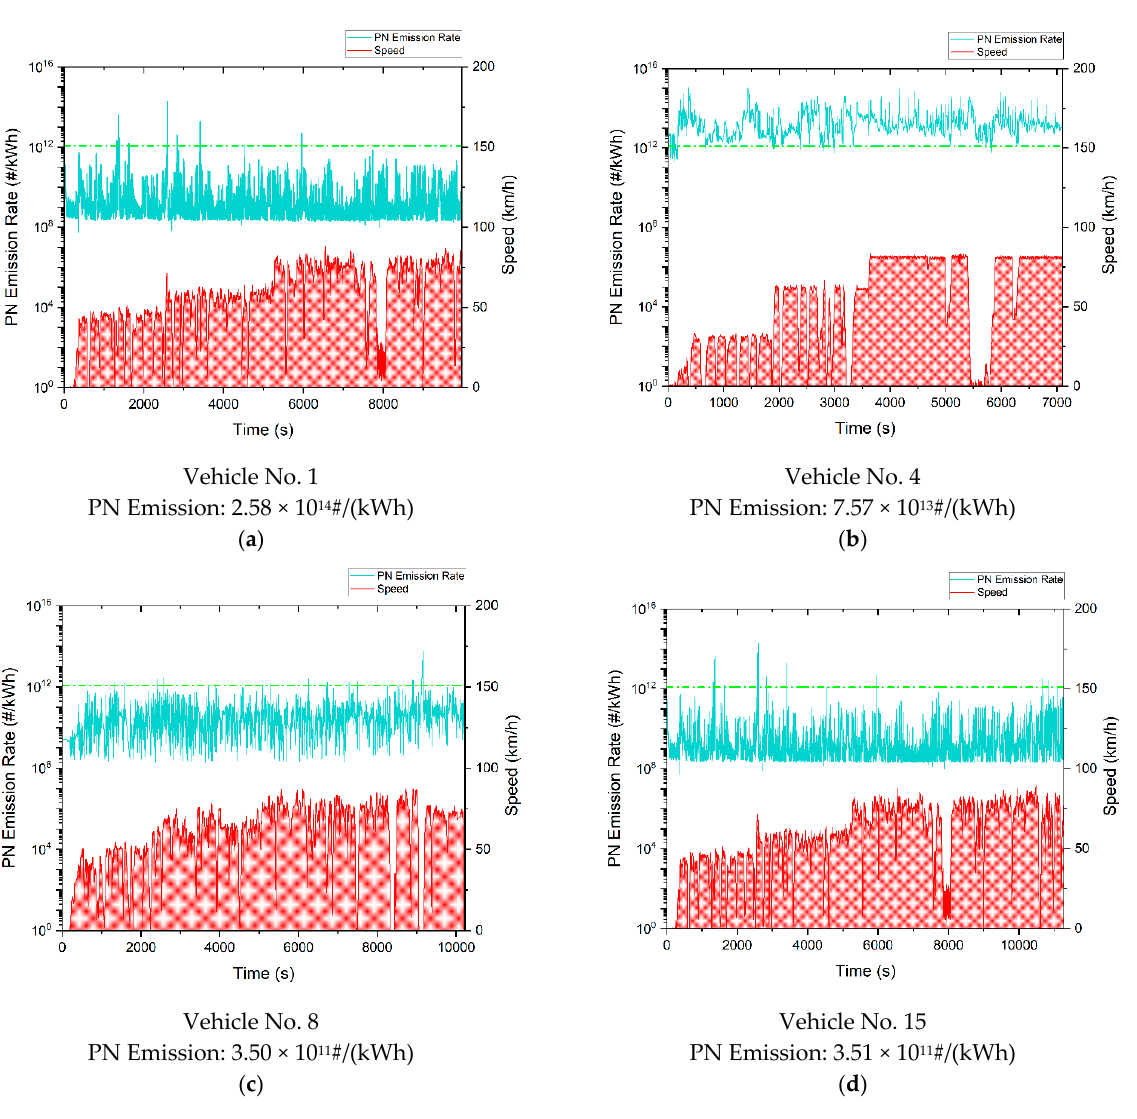
Figure A2. The relationship between the PN emission rate and speed over time of a typical test vehicle. ( a ) China-5 diesel vehicle; ( b ) China-6 diesel vehicles with malfunctioning DPFs; ( c ) China-6 diesel vehicles with intact DPFs; ( d ) China-6 NG vehicles.